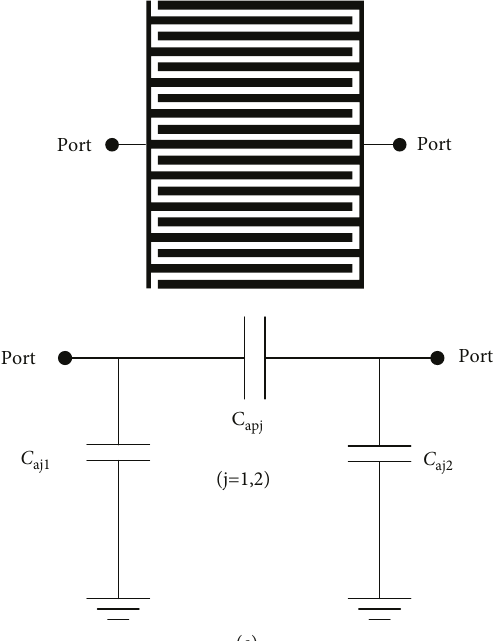
Figure 4: Each section of the 70.7 Ω ATL and their equivalent circuit: (a) section A1, (b) section A2, (c) section A3, (d) section A4, and (e) interdigital capacitor A j ( j = 1, 2